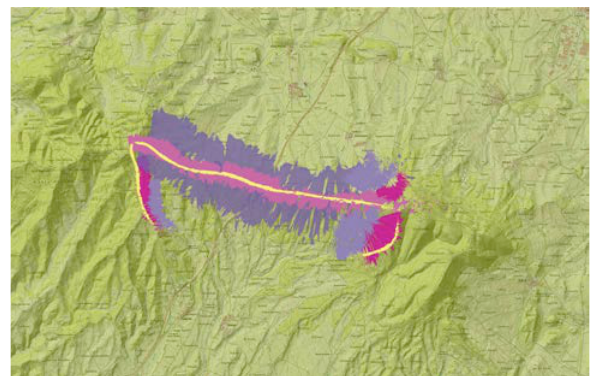
Figure 6. High quality areas.